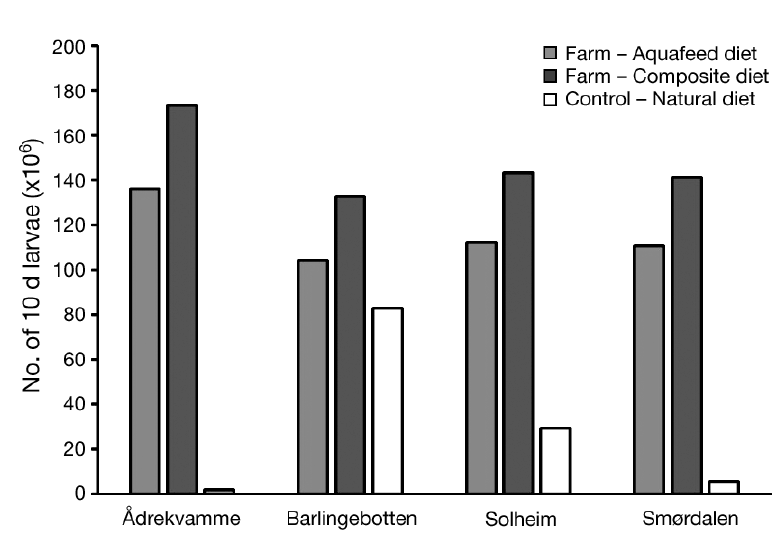
Fig. 5. Model output showing the number of Gracilechinus acutus 10 d old larvae (×10 6 ) present in the water column from a 1 m 2 section of fjord in both aquaculture and control locations, under aquafeed (light grey), composite (dark grey) and control (white) dietary